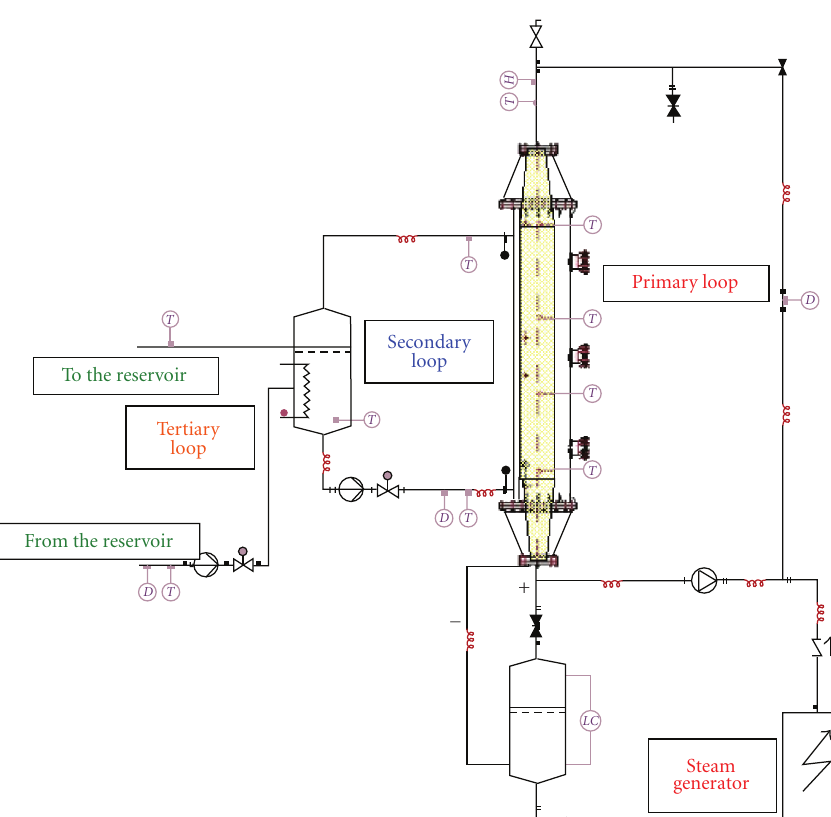
Figure 10: Flow diagram of the CONAN experimental facility.